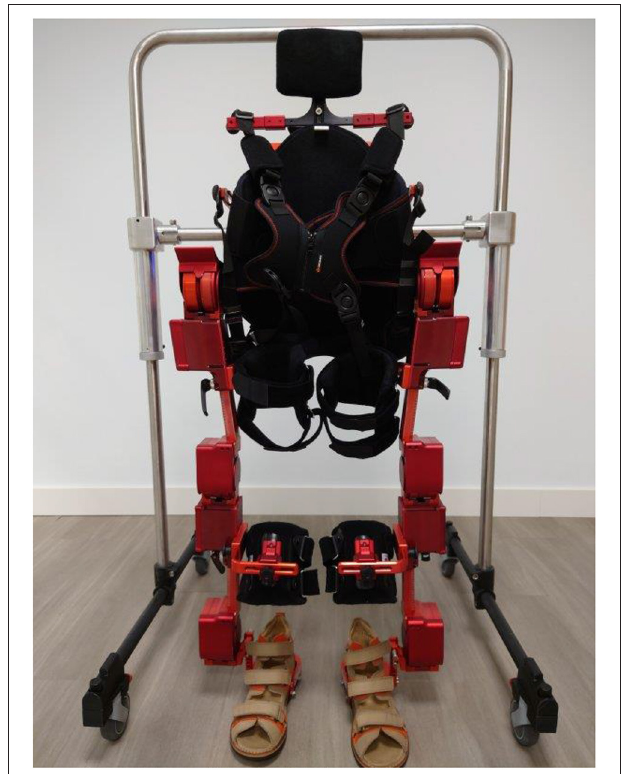
FIGURE 1 | ATLAS2030